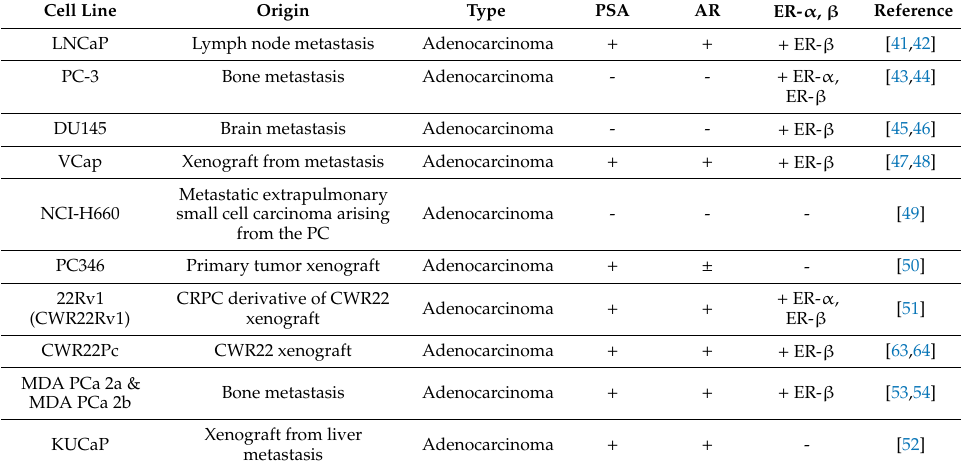
Table 1. Original PC cell lines and their pathological type, origin, prostate-specific antigen (PSA) reactivity, and expression level of androgen receptor (AR) and estrogen receptor